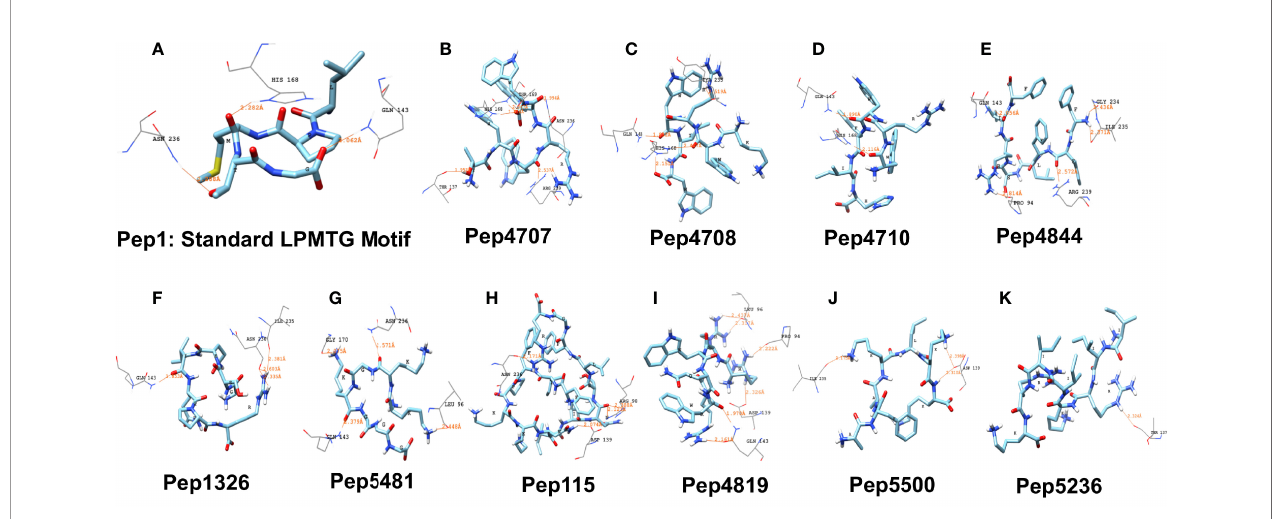
FIGURE 4 | Representative results from in silico molecular docking for the standard pilin subunit LPMTG and select AMPs with the semi-open lid conformation of the C. striatum sortase C protein. (A) The standard LPMTG motif is predicted to form hydrogen bonds with His168, Asn236, Gln143 (B) Pep4707 is predicted to interact with HIS168, ARG239, ASN236, THR137, THR169 (C) Pep4708 is predicted to interact with HIS168, HIS168, GLN143, TYR233 (D) Pep4710 is predicted to interact with HIS168, GLN143 (E) Pep4844 is predicted to interact with ARG239, GLN143, PRO94, ILE235, GLY234 (F) Pep1326 is predicted to interact with ASN236, ASN236, GLN143, ILE235 (G) Pep5481 is predicted to interact with ASN236, GLN143, LEU96, GLY170 (H) Pep115 is predicted to interact with ASN236, ASP139, ARG98, ARG98 (I) Pep4819 is predicted to interact with GLN143, GLN143, ASP139, LEU96, LEU96, PRO94 (J) Pep5500 is predicted to interact with ASP139, ASP139, ILE235 (K) Pep5236 is predicted to interact with THR137. Images made using UCSF